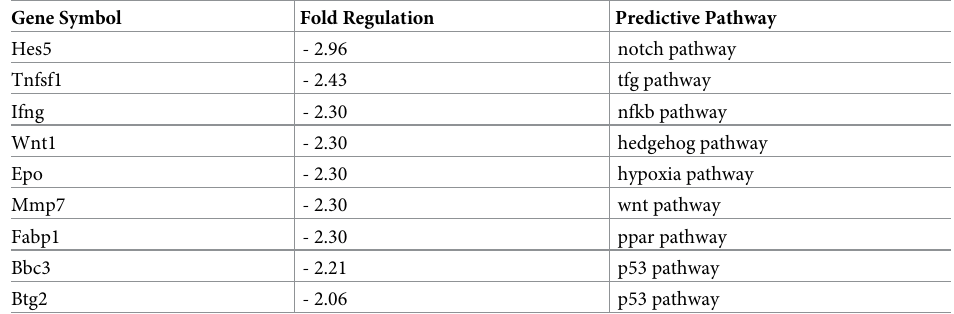
Table 1. Genes expressed following 532 nm laser exposure at low irradiance of 0.1 W/cm 2